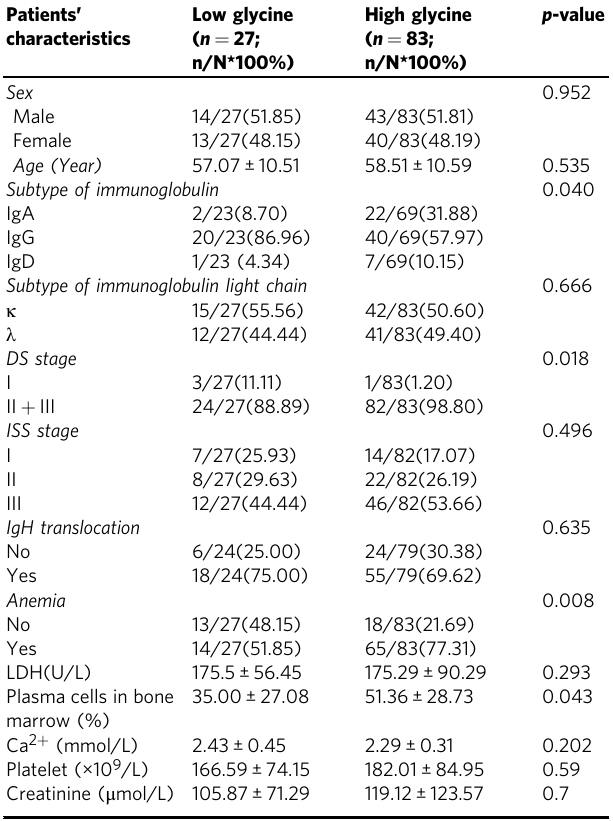
Table 1 The correlations between glycine concentration and clinical characteristics of MM